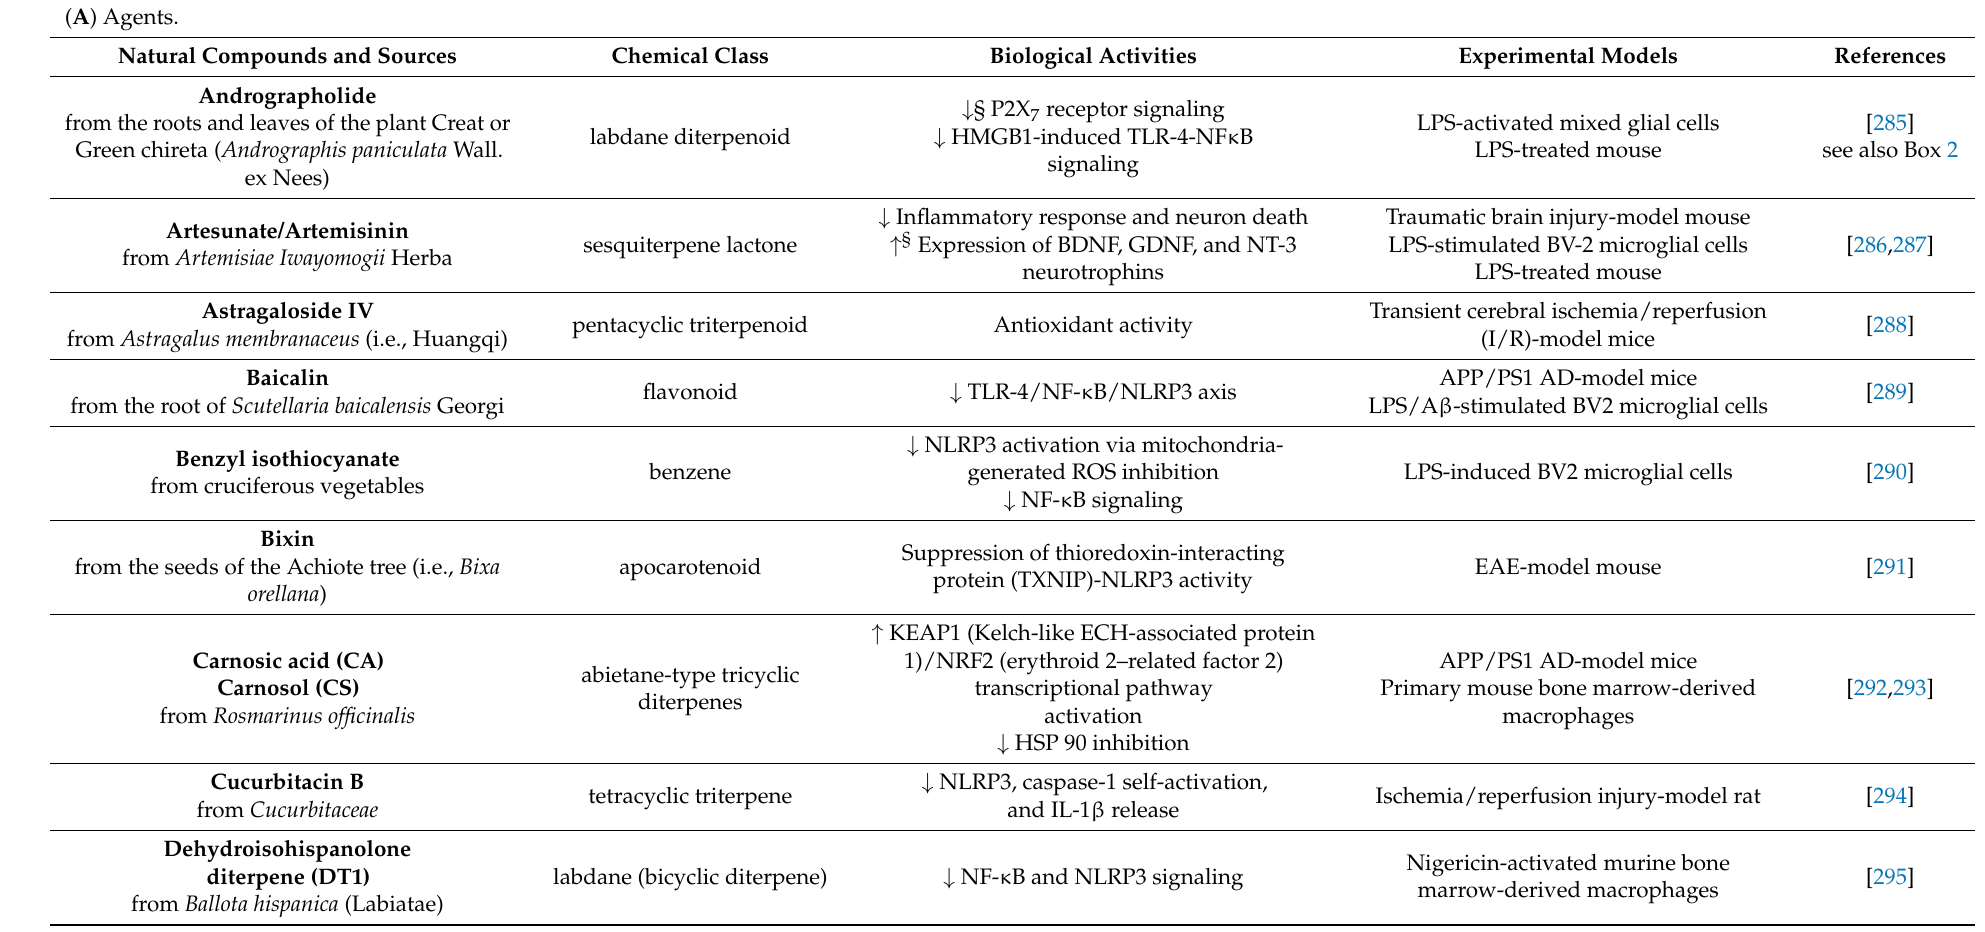
Table 4. Brain NLRP3 inflammasome downregulation by officinal plants